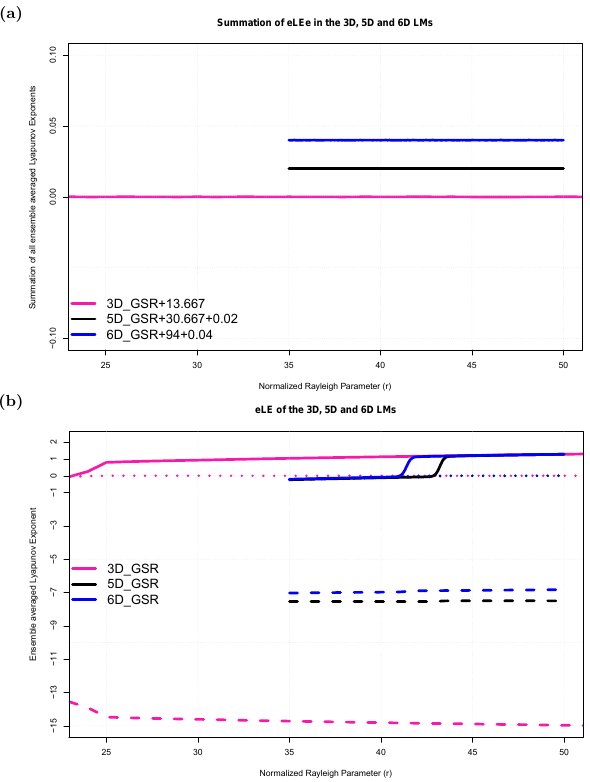
Figure A1. The summation of all ensemble-averaged Lyapunov exponents (eLEs) in the LMs (a) and three leading ensemble- averaged Lyapunov exponents (eLEs) as a function of the normal- ized Rayleigh number ( r ) (b) . The pink, black, and blue lines indi- cate the eLEs for the 3-D, 5-D and 6-D LMs, respectively. The solid, dotted, and dashed lines display the first, second and third eLEs, re- spectively. In (a) , the pink, black, and blue lines are shifted with a constant value of 13.667, 30 . 667 + 0 . 02 and 94 . 0 + 0 . 04, respec- tively. To save computational resources, the eLEs of the 5-D and 6-D LMs are calculated over a shorter range of values for r (i.e., 35 < r < 50).